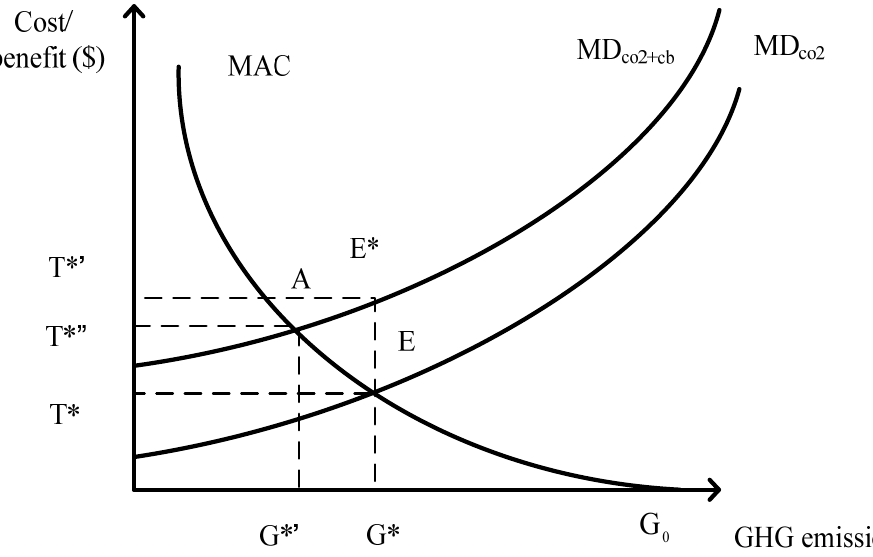
Figure 1. The efficient level of the carbon charge when accounting for health co-benefits.